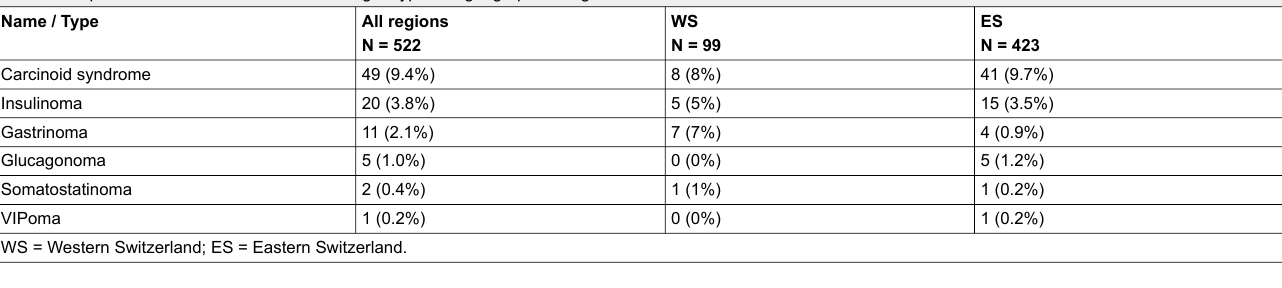
Table 2: Immunostaining. Number of NEN histologic samples that have been stained immunologically for chromogranin A or synaptophysin for diagnostic purposes.